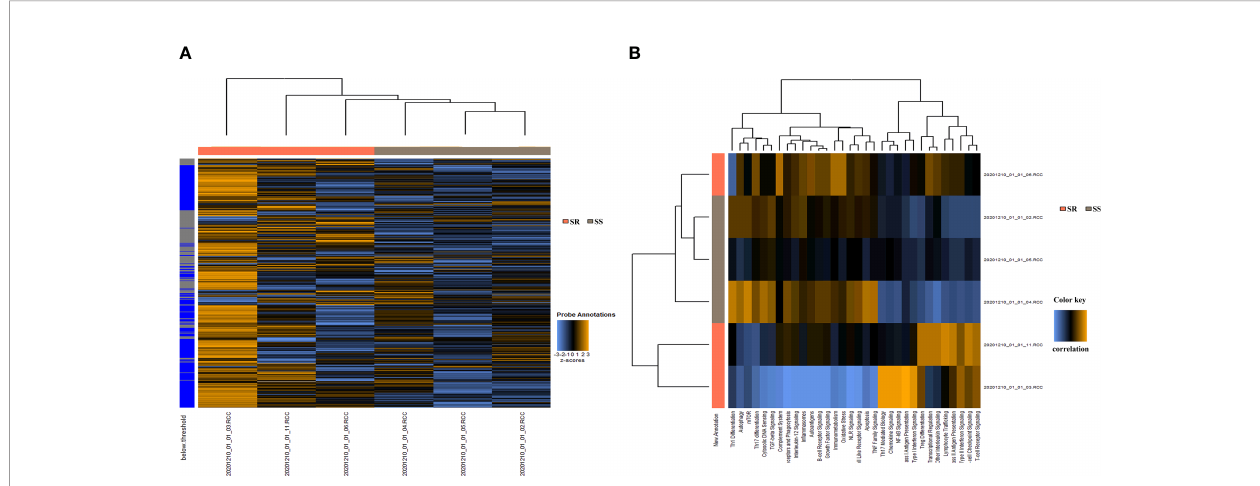
FIGURE 1 | Gene signature development in urinary sediment samples from children with SSNS ( n = 3) or SRNS ( n = 3). (A) 770 Gene expression in each sample. (B) Important pathways between the SSNS and SRNS